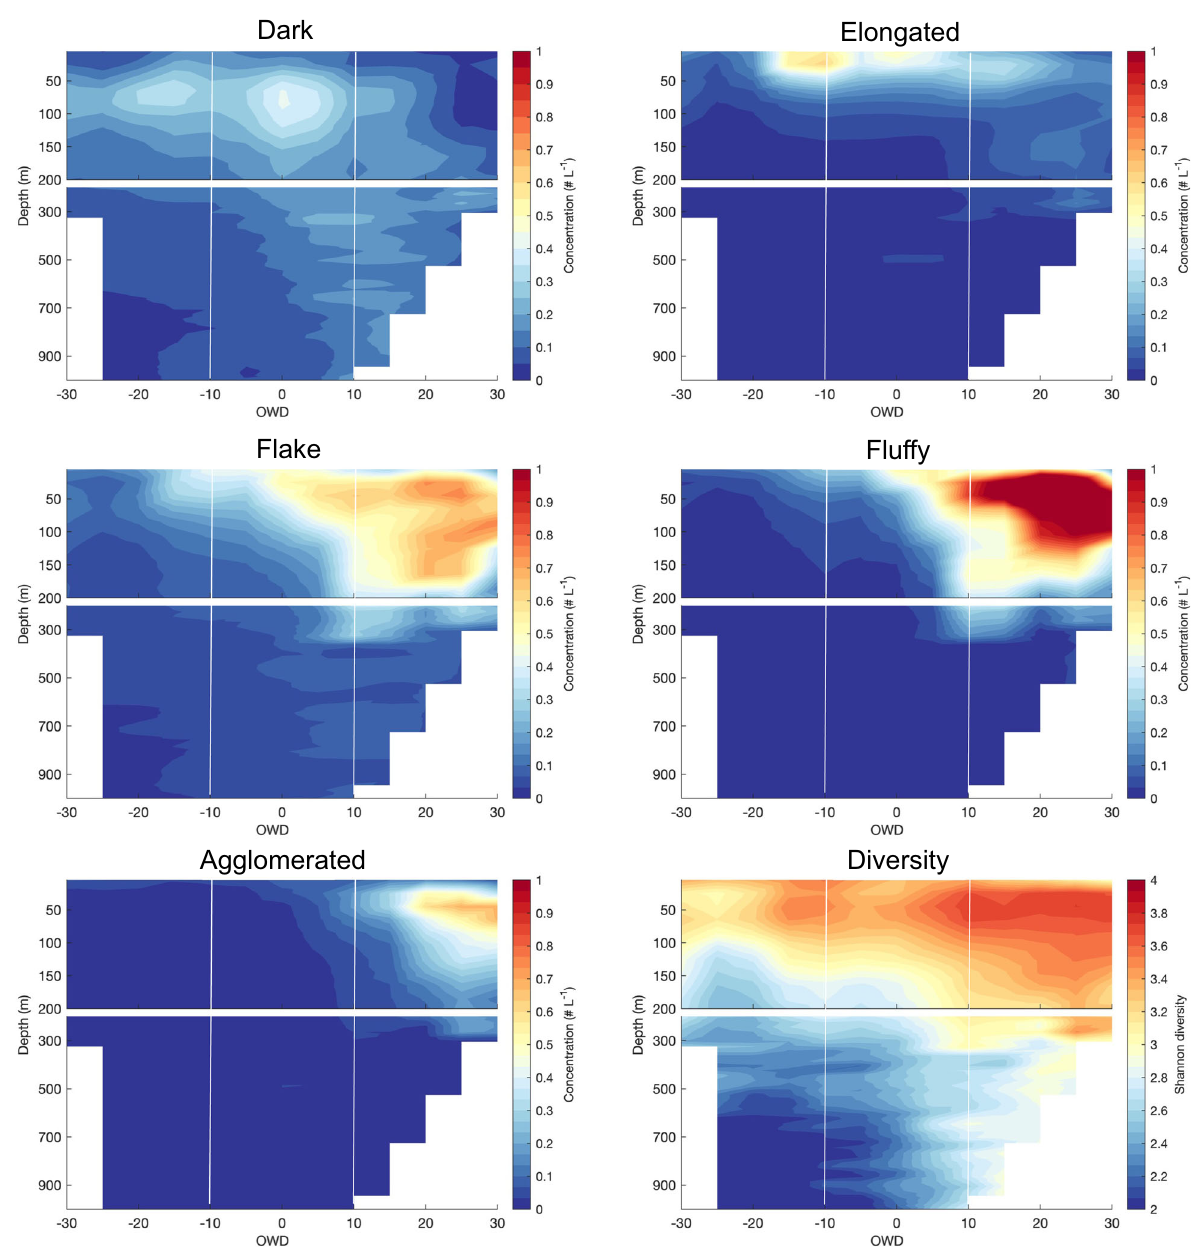
Fig. 3 Spatio-temporal distribution of marine snow morphotypes. Section plots of the concentration of various morphotypes of marine snow, their diversity (Shannon-Wiener index) over depth and time (open water days (OWD)) in the Baf fi n Bay. White vertical lines indicate the ranges of assigned periods (under ice, ice break-up,